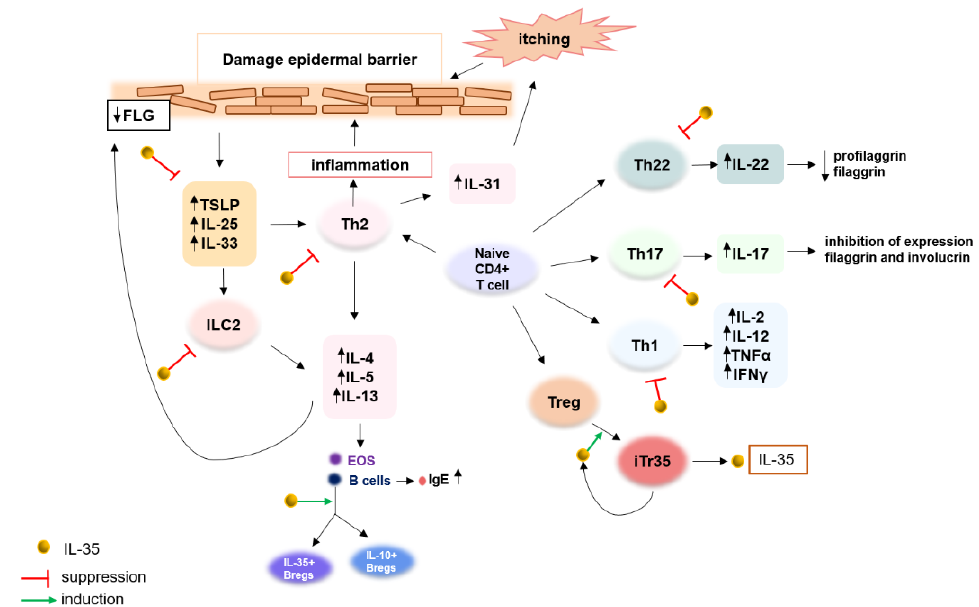
Figure 3. Potential involvement of IL-35 in the pathogenesis and its potential therapeutic effect in atopic dermatitis (AD). FLG (filaggrin), TSLP (Thymic stromal lymphopoietin), IL-25 (Interleukin 25), IL-33 (Interleukin 33), Th2 (T helper cells 2), ILC2 (Innate lymphoid type-2-cells), IL-4 (Interleukin 4), IL-5 (Interleukin 5), IL-13 (Interleukin 13), EOS (Eosinophils), IL-10+Bregs (IL-10-producing regulatory B cells), IL-35+Bregs (IL-35-producing regulatory B cells), IL-31 (Interleukin 31), Th22 (T helper cells 2), IL-22 (Interleukin 22), Th17 (T helper cells 17), IL-17 (Interleukin 17), Th1 (T helper cells 1), IL-2 (Interleukin 2), IL-12 (Interleukin 12), TNF α (tumor necrosis factor alfa), INF γ (Interferon gamma), Treg (Regulatory T cells), iTr35 (IL-35-producing T cells), IL-35 (Interleukin 35). This figure presents the main cytokines involved in AD pathogenesis, the links between them, and their roles, indicated by black arrows. IL-35 may have anti-inflammatory effects in AD via the possible inhibition of Th1, Th2, Th17, and Th22 cell responses. IL-35 can induce the conversion of B cells into regulatory B cells that produce IL-35 as well as IL-10. IL-35 can also induce iTr35 cell generation, which releases an additional amount of IL-35, creating a positive feedback loop. The green arrows indicate induction effects and the red T-shaped ends indicate suppression